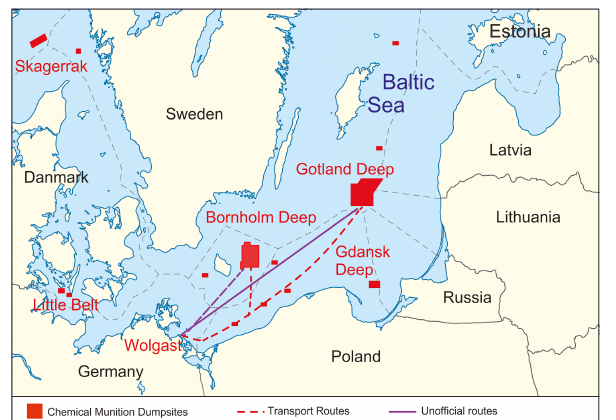
Figure 4. Chemical munition dump sites in the Baltic Sea (courtesy of Jacek Bełdowski, CHEMSEA project